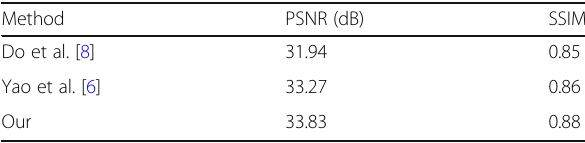
Table 3 Result contrast for “ BreakDancers ” sequence Method